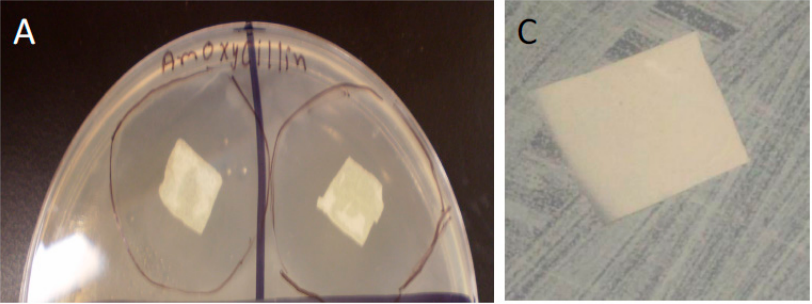
Figure 8. Cont. Figure 8. Cont.